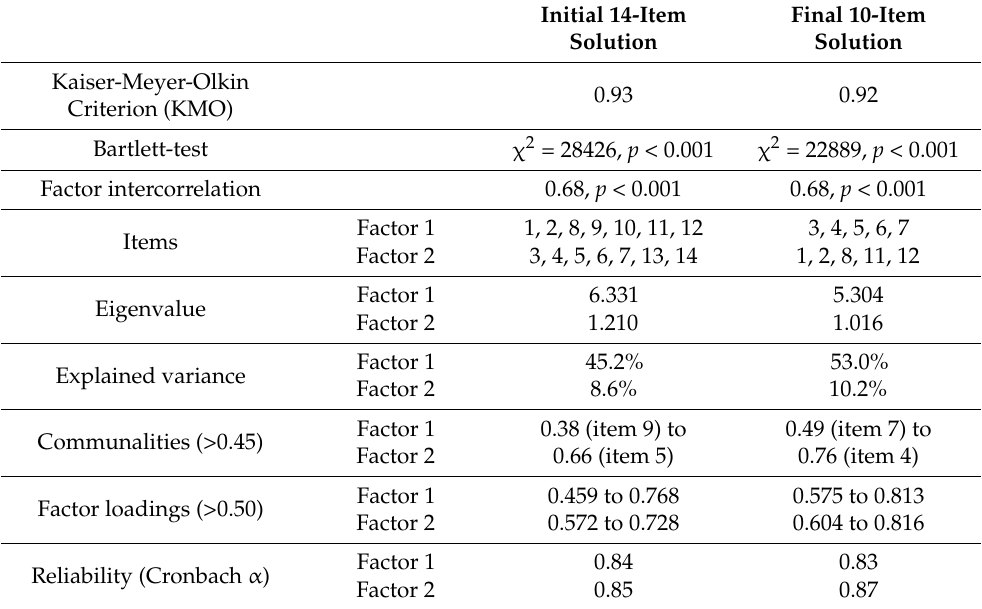
Table 2. Initial and final principal component analysis (PCA)-solution of the Health Promoting School (HPS) implementation